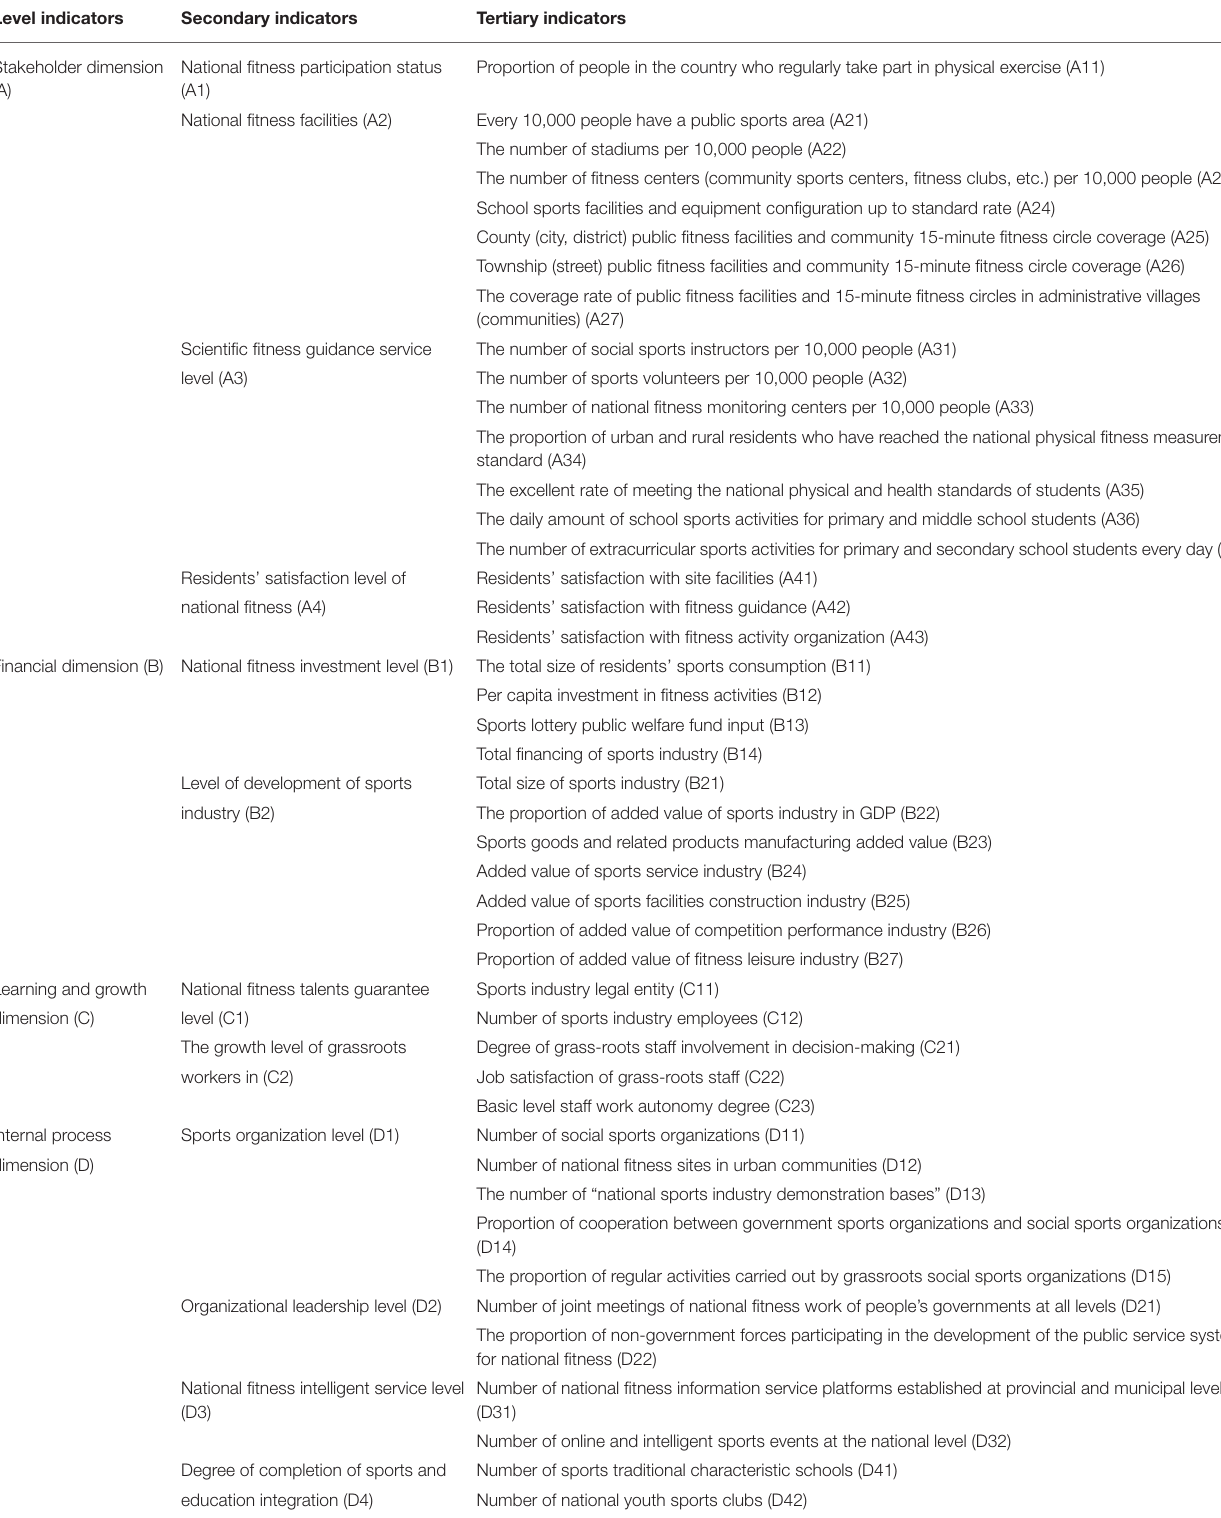
TABLE 5 | Final results of national fitness development index evaluation